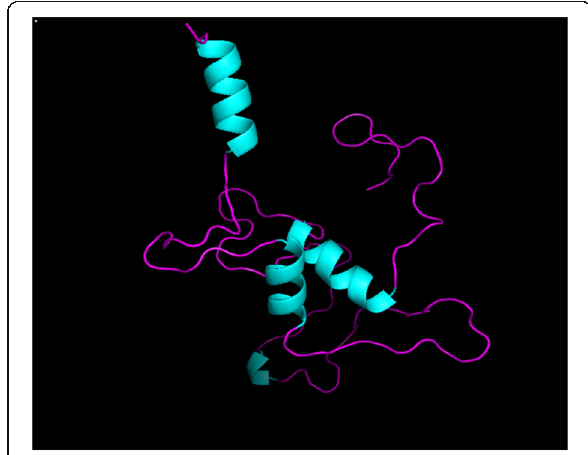
Fig. 15 Visualization of the 3D structure of S.AMP13 by using PyMOL Molecular Graphics